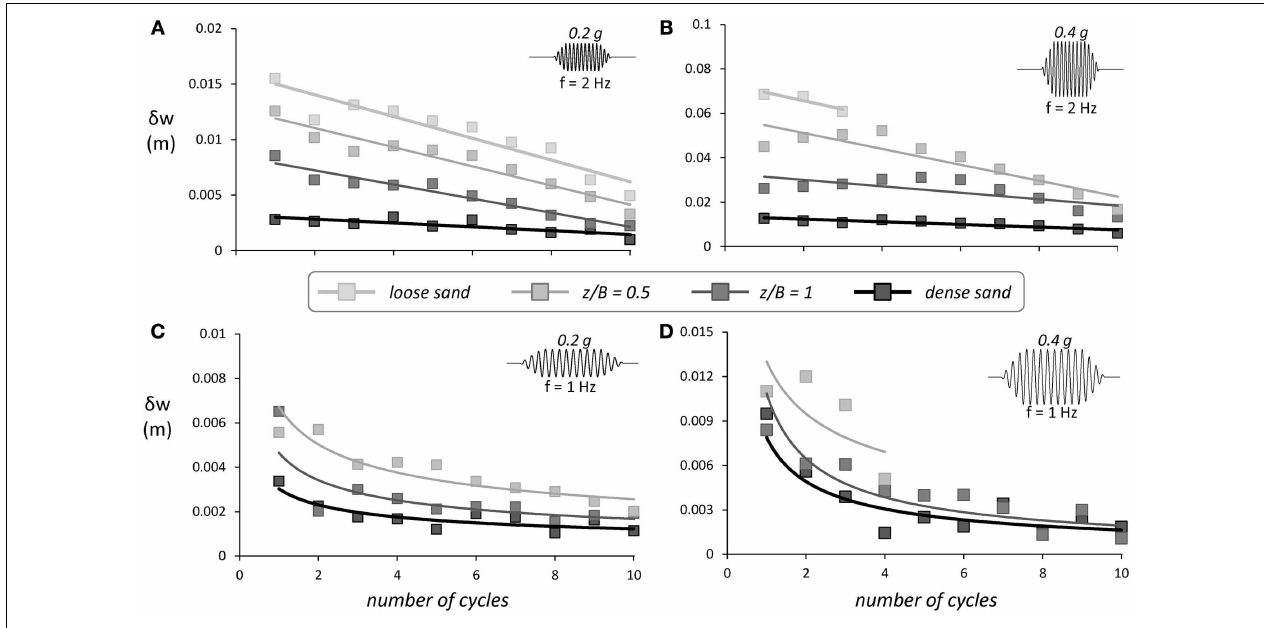
Foundation settlement per cycle for our different sinusoidal excitations: (A) f = 2Hz, a = 0.2g; (B) f = 2Hz, a = 0.4g; (C) f = 1Hz, a = 0.2g; and (D) f = 1Hz, a =